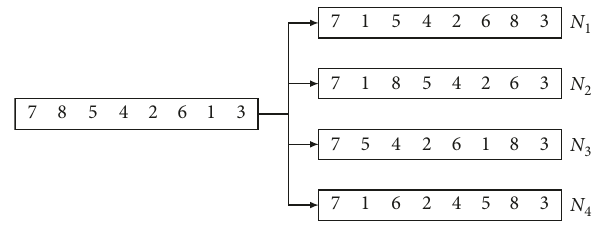
Figure 3: Neighborhood